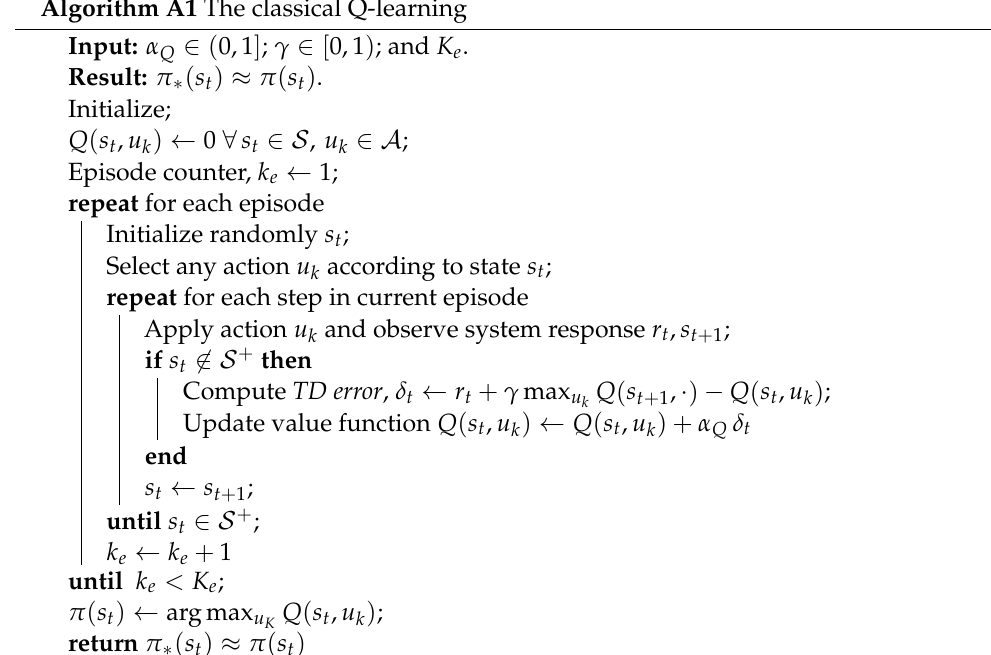
Algorithm A1 The classical